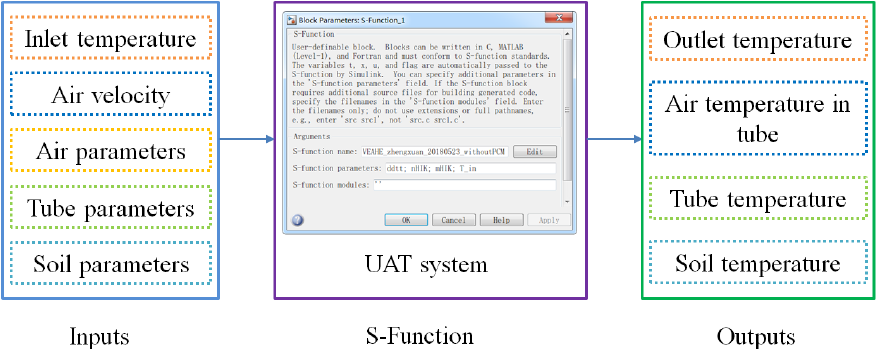
Figure 1. The parameter calculation of system’s thermal performance through the MATLAB/SIMULINK platform using S-Function. platform using